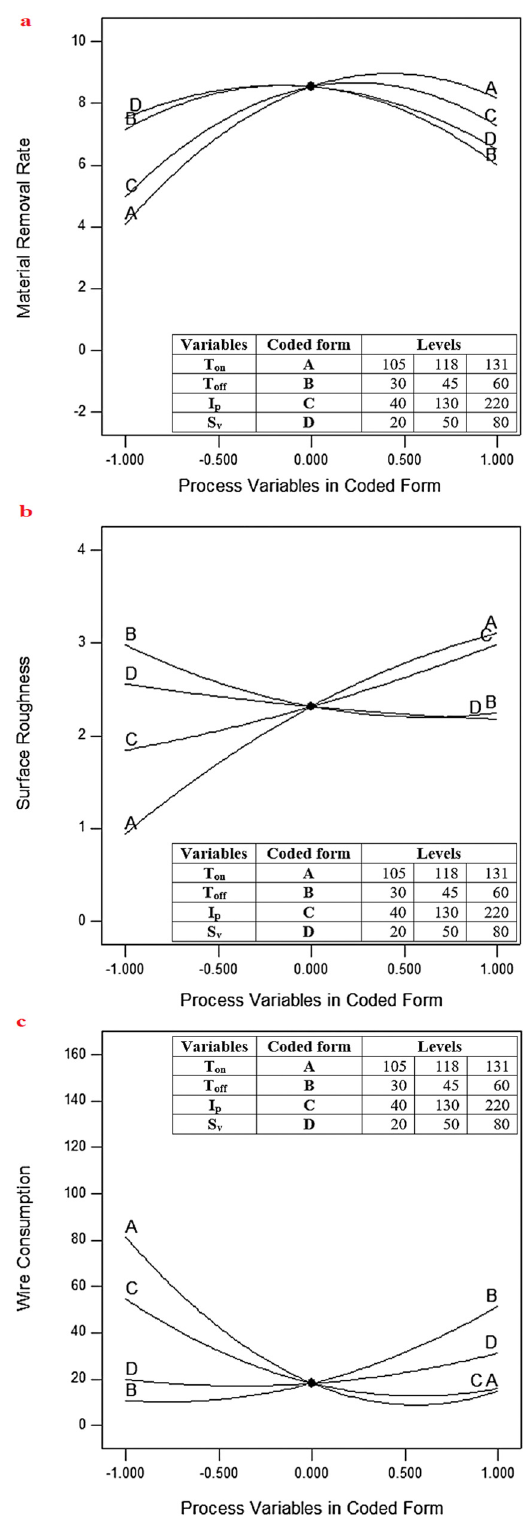
Figure 4: Various input factors ’ e ff ect on: ( a ) MRR, ( b ) SR, and ( c )